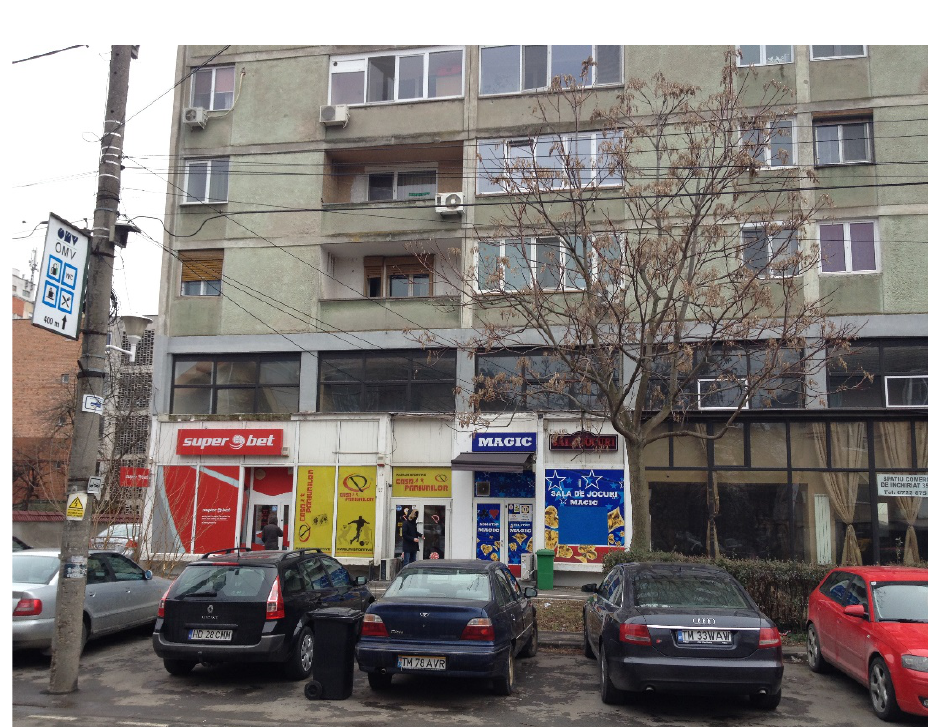
Figure 1: Association of gambling facilities in Eroilor de la Tisa Street (from left to right): Super Bet (sports betting), Casa pariurilor (Gambling house - sports betting), and Magic (slot machines, roulette). All have the same address: Eroilor de la Tisa Street 10 -12 Source: Sorina VOICULESCU, 2017